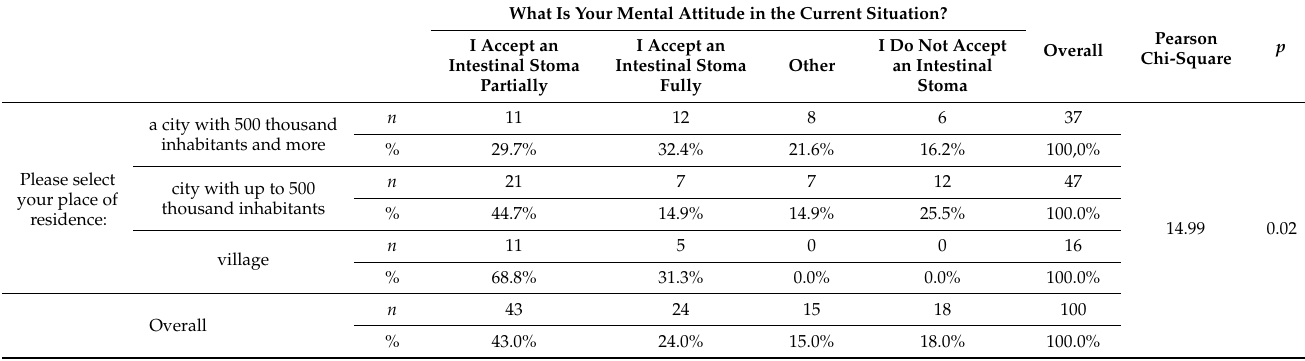
Table 5. Intestinal stoma acceptance and place of